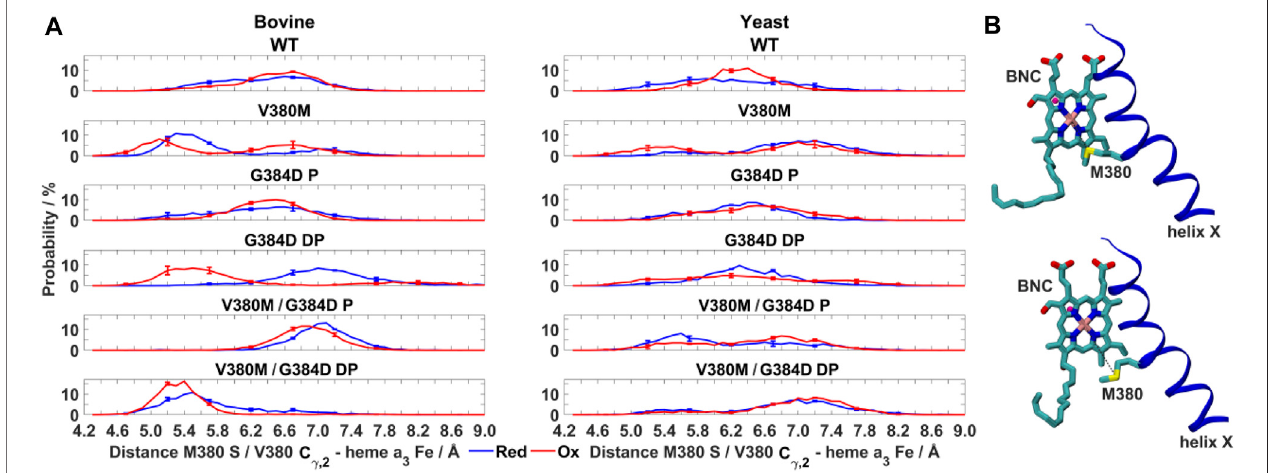
FIGURE6| DynamicsofV380M mutant inbovineand yeastC c O. (A) Probability distribution (%)ofV380/M380 – heme a 3 Fe distance in WT,V380M, and V380M/ G384D(P/DP)bovine (left) andyeast (right) C c Osintheirfullyreducedandoxidizedstates. (B) ConformationoftheBNCandTMHXinbovineV380MC c Osimulations. Residue M380 is labelled. The M380 S – heme a 3 Fe distance (short, top and long, bottom) is indicated by dashed black lines. The distributions are averaged over all simulation replicas and error bars correspond to standard deviations.